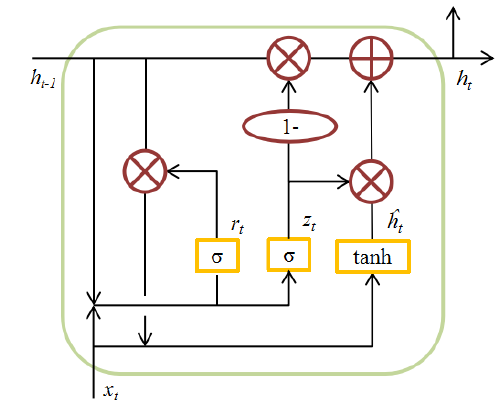
Fig. 5 An example of GRU